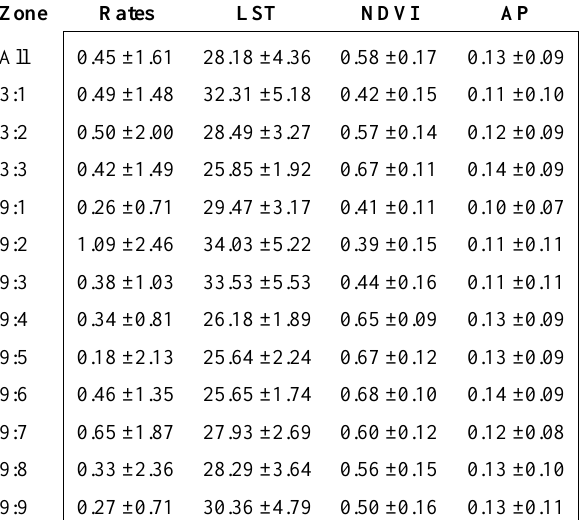
Table 3: Descriptive Statistics of outcome and predictors. Overall, the correlation between the monthly values of rates and the environmental variables was near zero (which is confirmed by a more detailed analysis). There was moderate correlation among the environmental variables (Figure 3), which did not warrant collinearity.